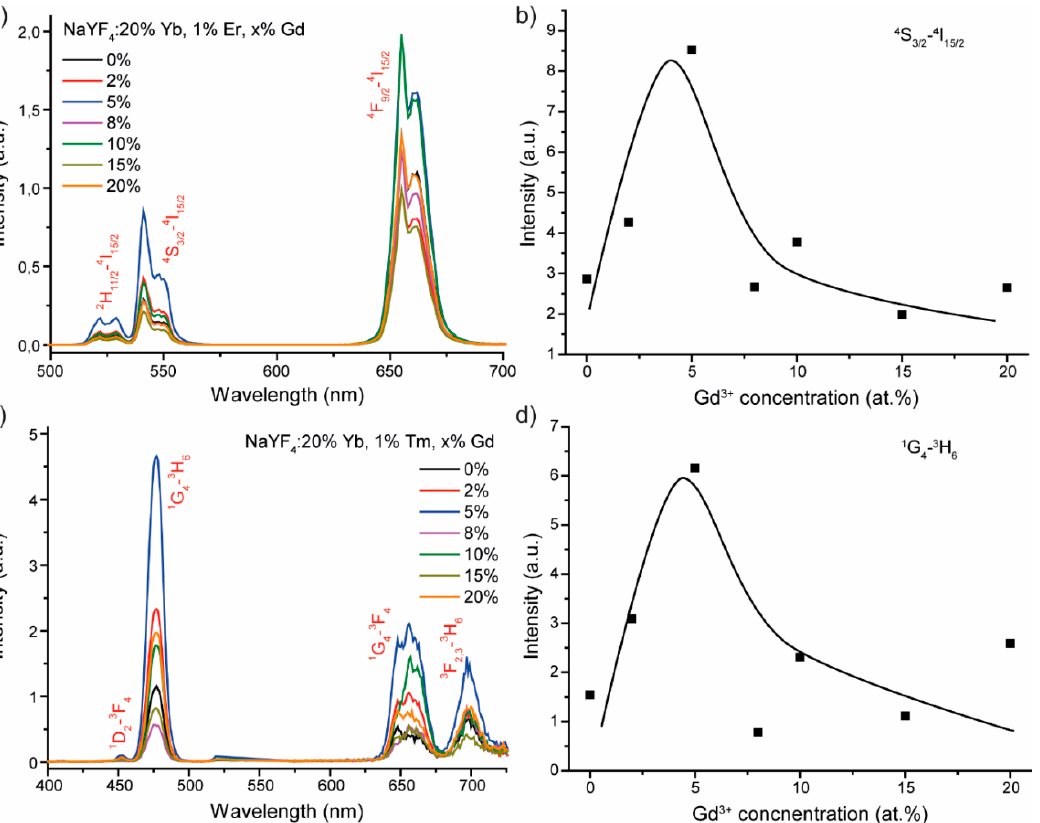
Figure 5. ( a ) Upconversion luminescence of NaYF 4 : 20% Yb, 1% Er microparticles with different Gd 3+ concentrations, ( b ) the dependence of green emission (541 nm) intensity on the Gd 3+ amount, ( c ) upconversion luminescence of NaYF 4 : 20% Yb, 1% Tm microparticles with different Gd 3+ concentration, and ( d ) the dependence of blue emission (477 nm) intensity on the Gd 3+ amount. + Upconversion intensity enhancement by Gd 3 co-doping of NaYF 4 : Yb, Er or NaYF 4 :